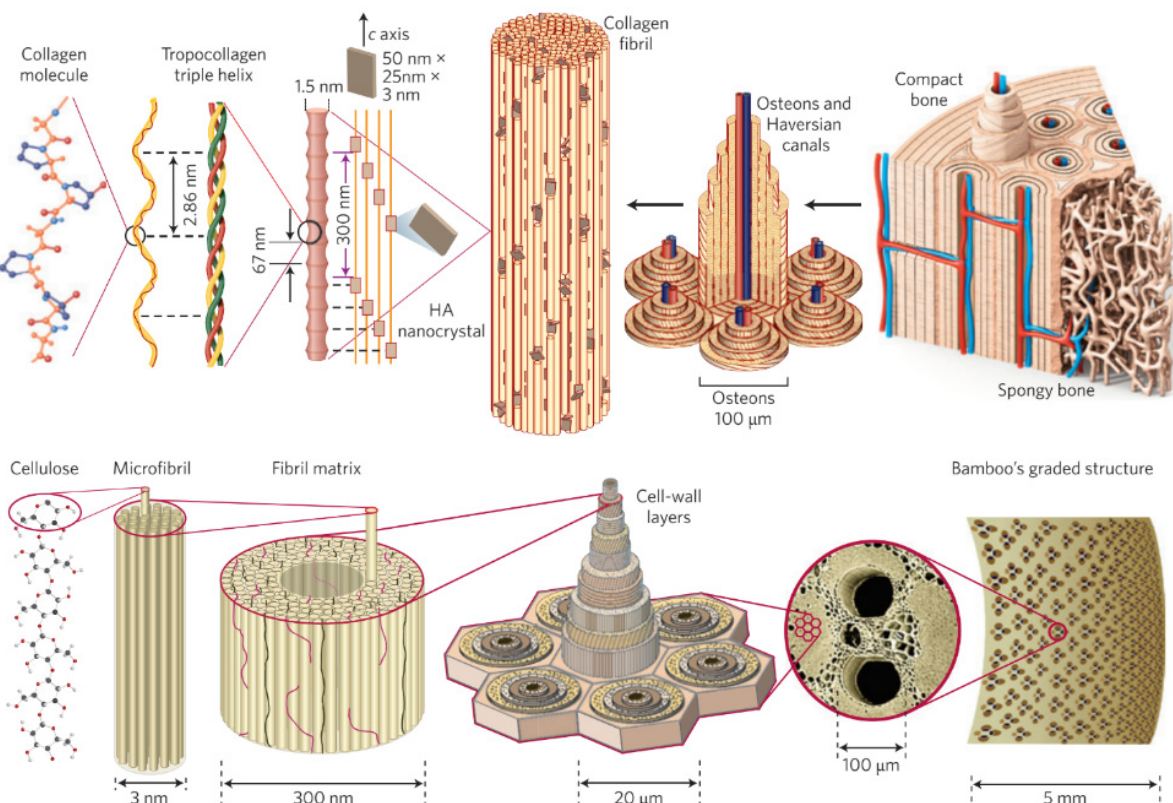
Figure 11. Comparison of the hierarchical structures of bone and bamboo. Reproduced with per- mission from [149]. Copyright: Nature Publishing